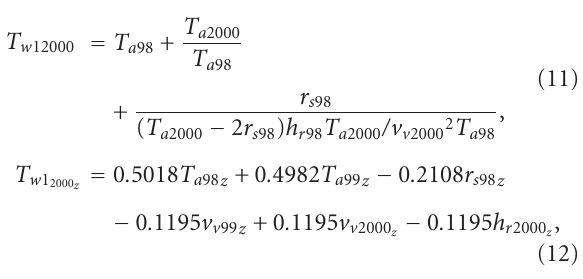
Figure 9: Comparison between measured and estimated data (11), correlation coe ffi cient r Tw , Tw 1 = 0 .